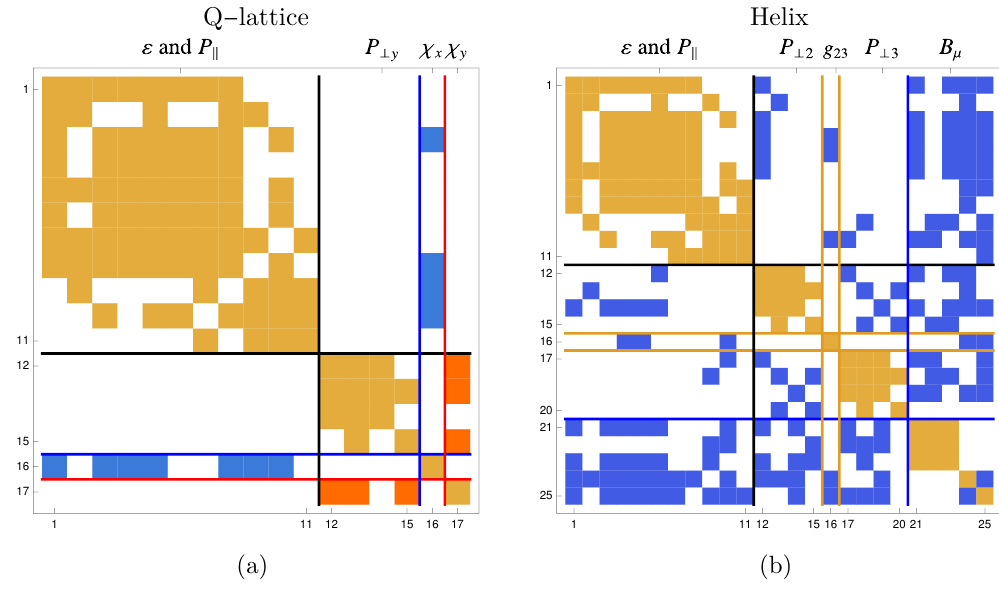
Figure 8. Overlap between the linear perturbation